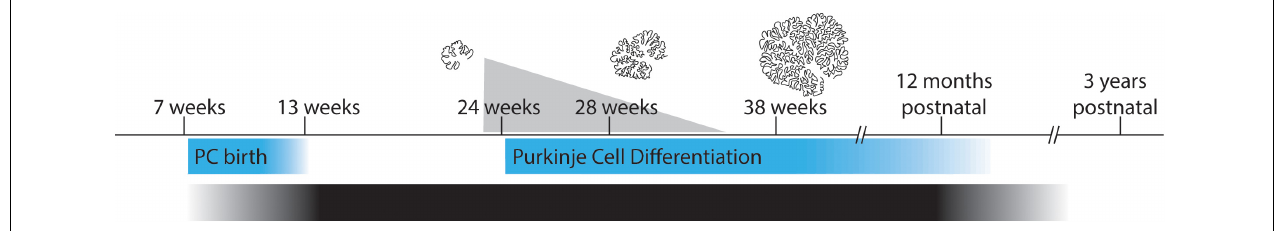
FIGURE 3 | Purkinje cell differentiation, cerebellar expansion, and sensitive periods for developmental disorders. Pictured are various correlations along the time line of gestation through early childhood. Pictured in the upper portion of the figure is a scaled representation of cerebellar size and foliation during gestation. Adapted from Rakic and Sidman (1970) with permission obtained from Wiley Online Library. The superimposed gray triangle represents the incidence of developmental comorbidities associated with premature birth at the corresponding gestational ages. Below the time line in blue are the gestational ages of Purkinje cell birth and differentiation. (Bottom) A gradient showing the time period during which all etiologies of autism are thought to occur. Figure adapted in part from Sathyanesan et al. (2019) with permission obtained from Nature research